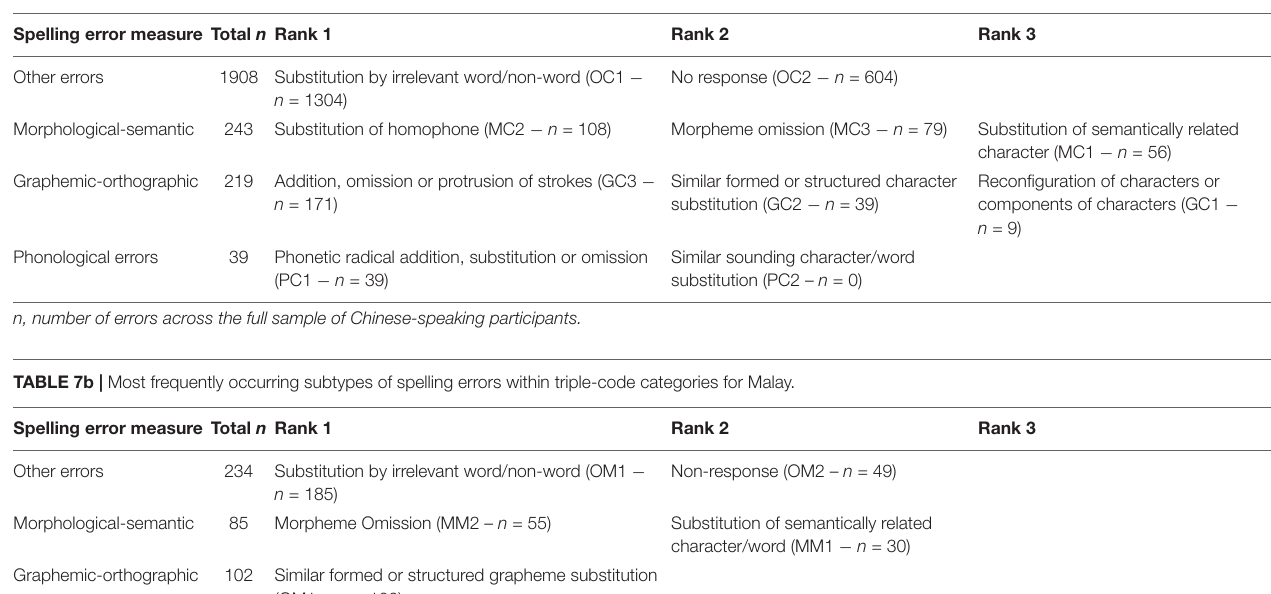
TABLE 7a | Most frequently occurring subtypes of spelling errors within triple-code categories for Chinese.